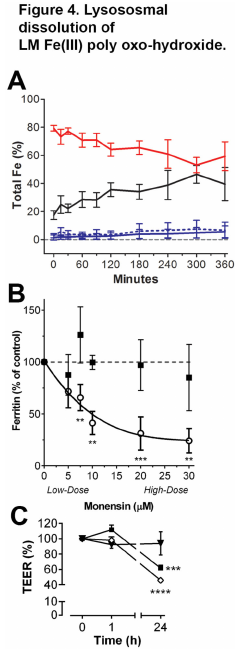
Figure 4. Lysososmal dissolution of LM Fe(III) poly oxo- hydroxide. A , Solubility in simulated lysosomal conditions at pH 5.0 with 10 mM citric acid and 0.15 M NaCl. Soluble Fe was measured by ICP-OES following 5 min ultrafiltration (3000 Da MWCO) for the LM Fe(III) poly oxo-hydroxide (black) and for un-modified Fe(III) poly oxo-hydroxide (solid